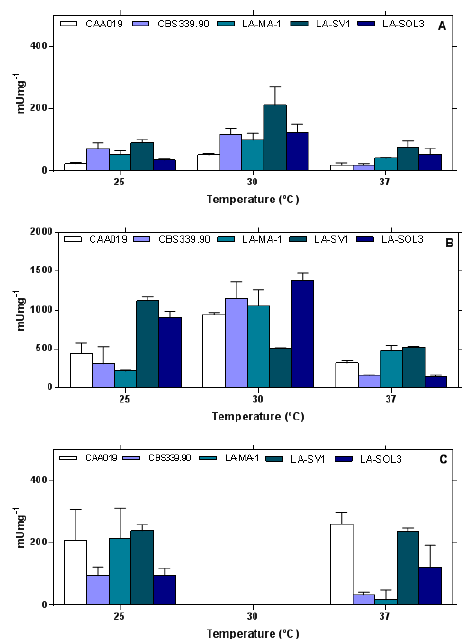
Figure 3. Extracellular endoglucanolytic ( A ), proteolytic ( B ) and lipolytic ( C ) activities of the 5 strains of L. theobromae grown at 25 °C, 30 °C and 37 °C and tested at the same temperature of growth. Data is presented as average ± standard deviation, normalized for mycelium dry weight.